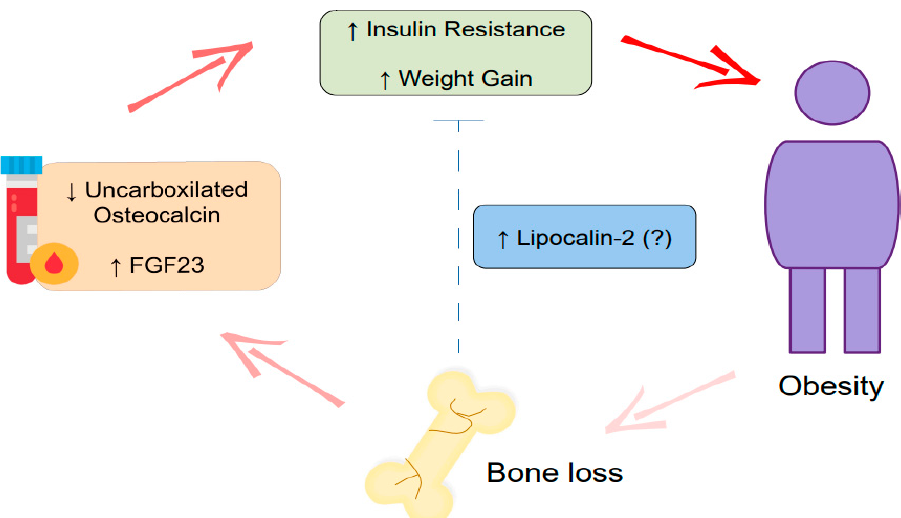
Figure 4. Obesity’s effects on osteokines secretion and bone loss. Obesity promotes bone dysfunctions that alter osteokine secretion. Serum uncarboxylated osteocalcin is reduced in subjects with